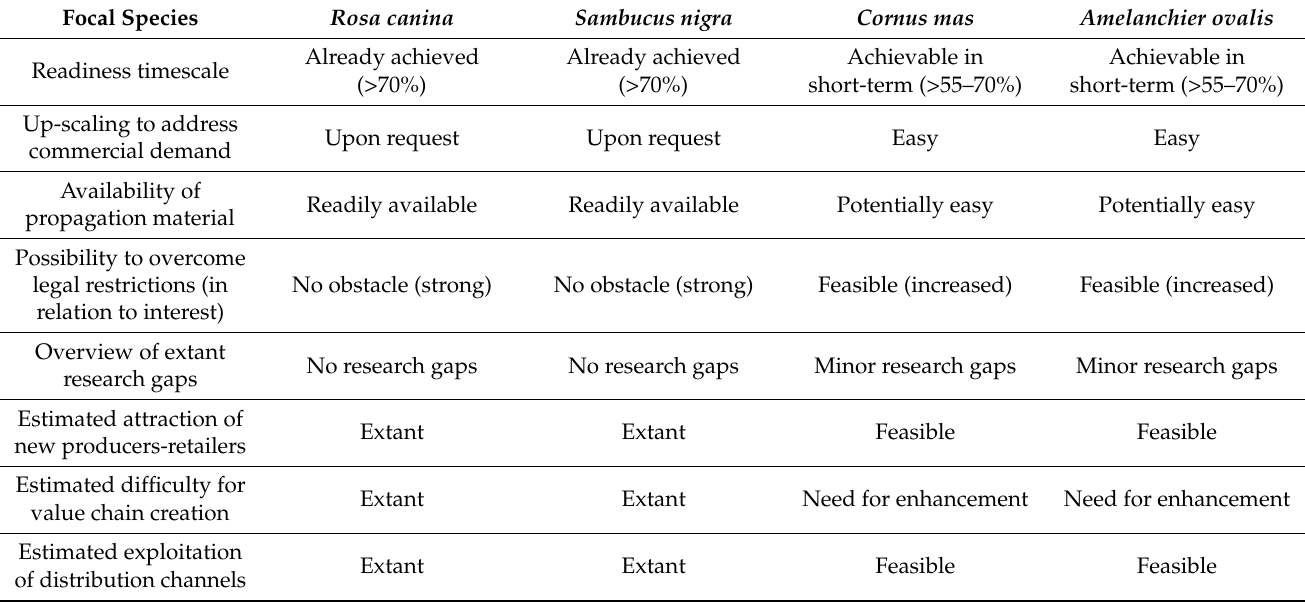
Table 2. Evaluation of the readiness timescale for sustainable exploitation of the four focal species studied herein ( Amelanchier ovalis , Cornus mas , Rosa canina , and Sambucus nigra ) according to the conditions and criteria designated by Krigas et al.